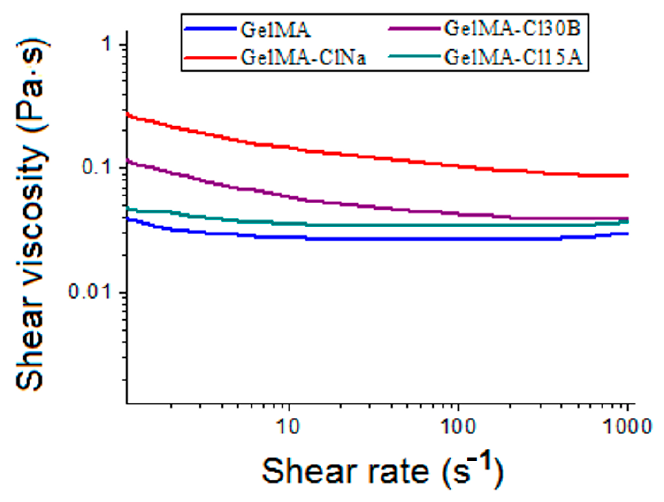
Figure 6. Shear viscosity versus shear rate of inks at 37 °C.